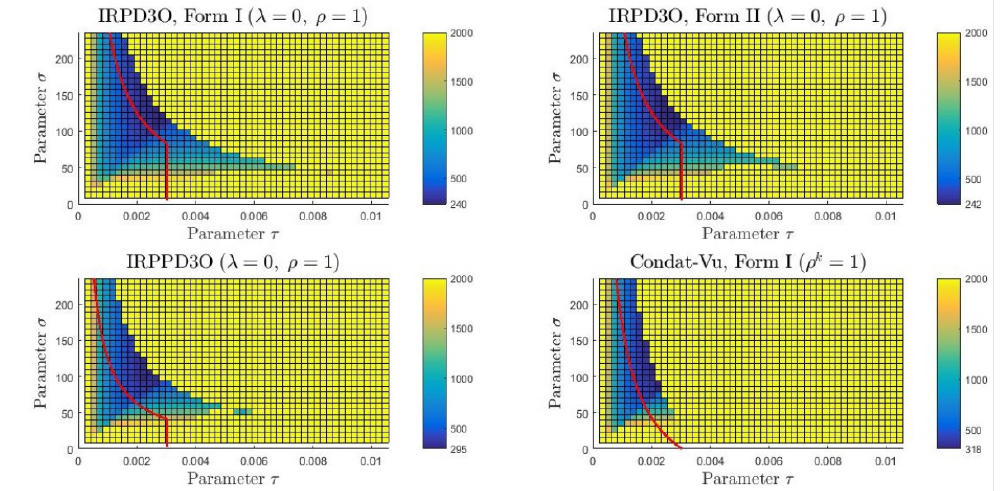
Figure 1 Number of iterations for an error of 10 −